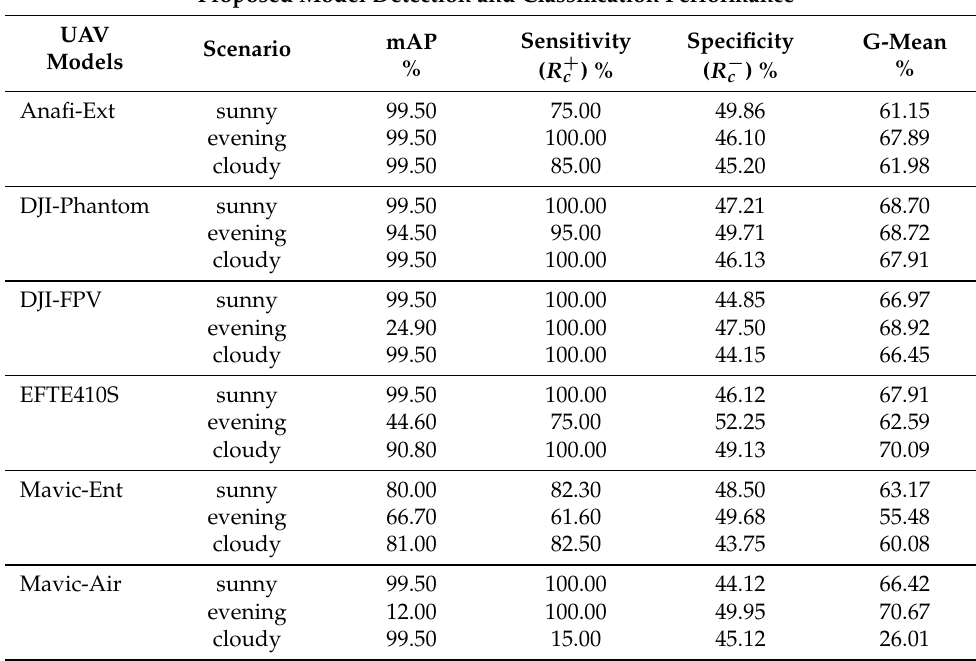
Table 4. UAV model detection and classification